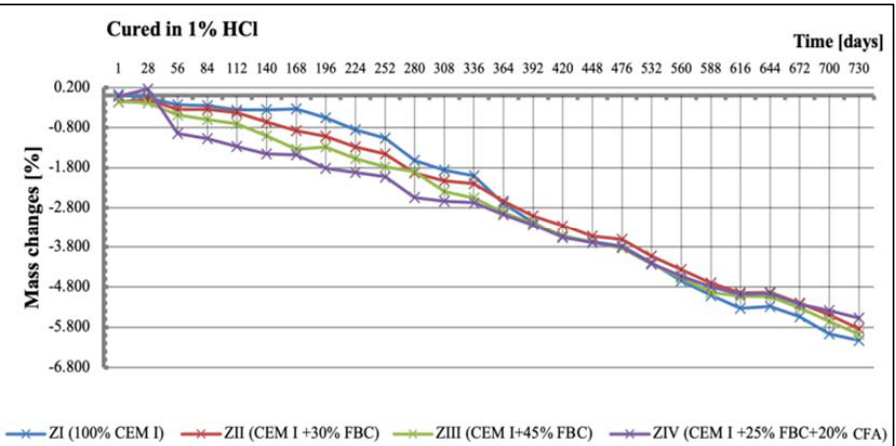
Figure 15. Mass changes of mortars cured in water for 730 days.